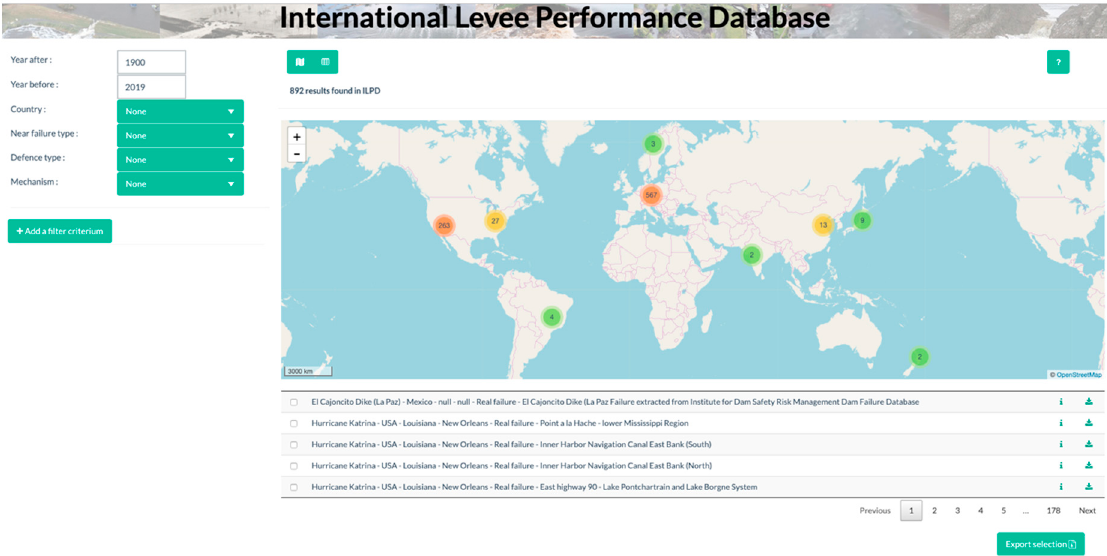
Figure 1. A screenshot of the opening page of the ILPD (leveefailures.tudelft.nl).